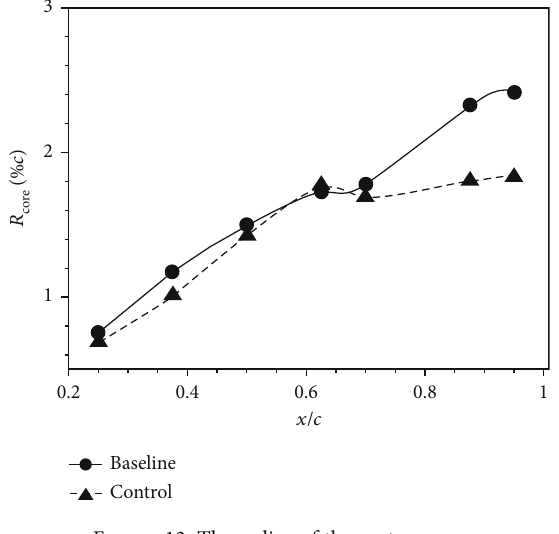
Figure 13: The radius of the vortex core.